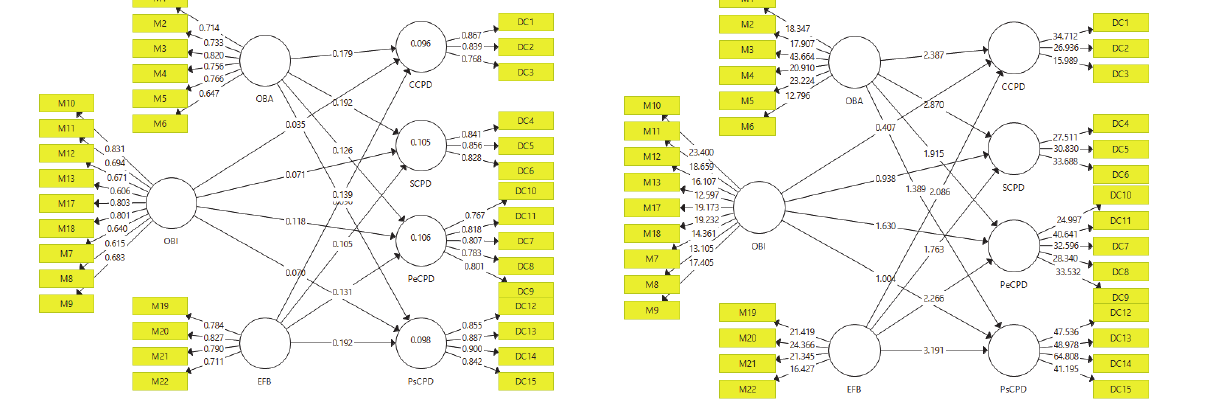
Fig. 3. Visual merchandising modeling in the purchase de-